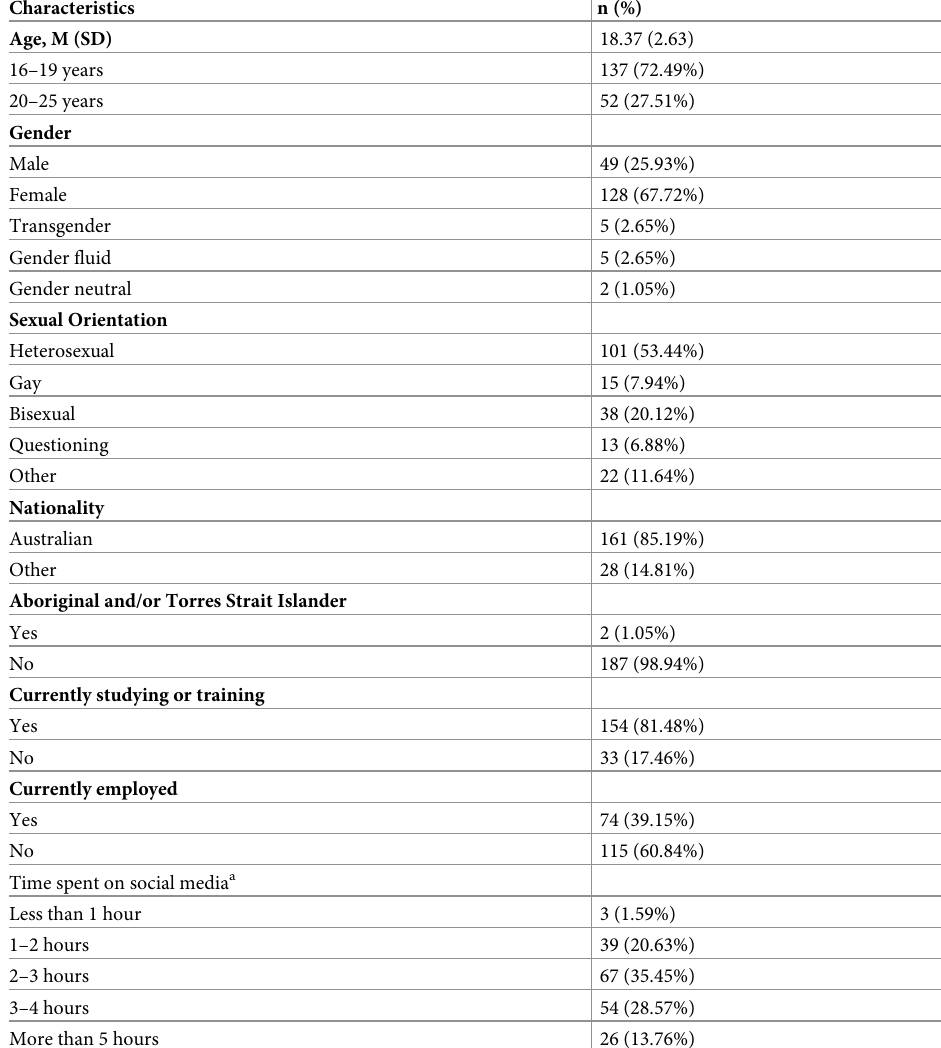
Table 2. Demographic characteristics and baseline social media usage of the